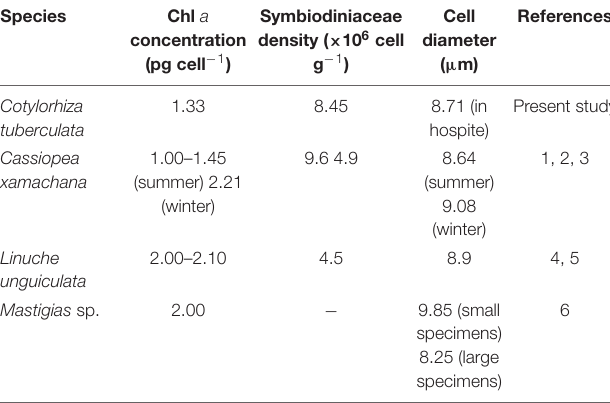
TABLE 3 | Comparison of biochemical C and N composition and C:N ratio expressed as percentage of dry mass (%DM) of symbiotic and non-symbiotic scyphozoan jellyfish: Cotylorhiza tuberculata, Aurelia aurita, Cyanea capillata, Chrysaora fuscescens, Chrysaora hysoscella, Cassiopea xamachana,